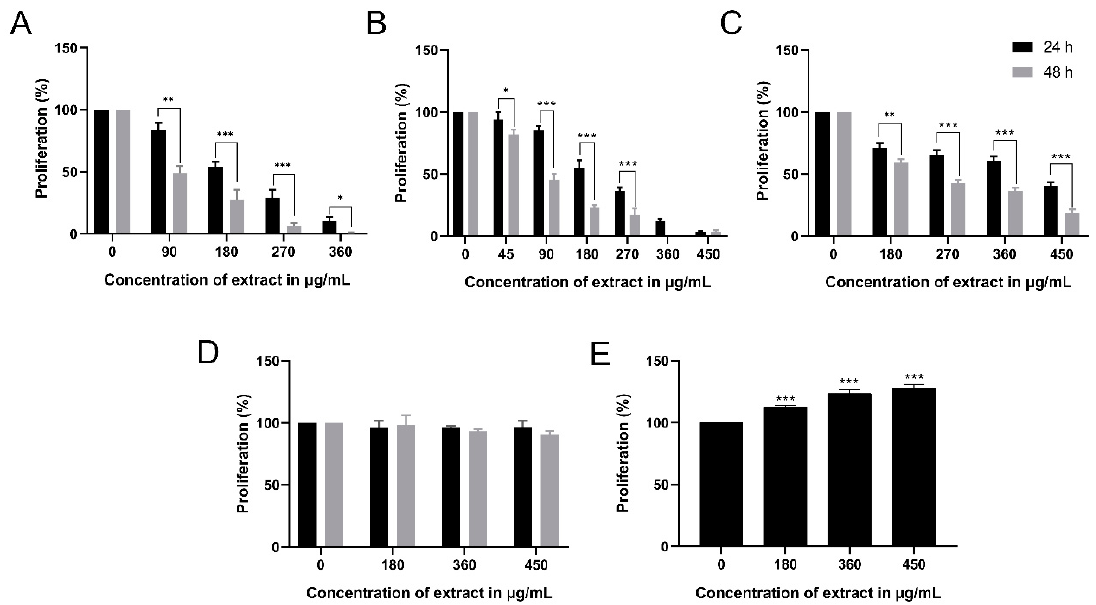
Figure 1. Proliferation of Monomac-1 ( A ), KG-1 ( B ), U937 ( C ), mesenchymal stem cells (MSCs) ( D ), and normal mononuclear cells MNCs ( E ), after 24 h and 48 h of treatment with methanolic leaf extract (MMLE). A significant dose- and time-dependent inhibition of proliferation of the three AML cell lines was noticed with increasing concentrations of MMLE. Significant differences were reported with * indicating a p -value: 0.01 < p < 0.05, ** indicating a p -value: 0.001 < p < 0.01 and *** indicating a p -value: 0.0001 < p <